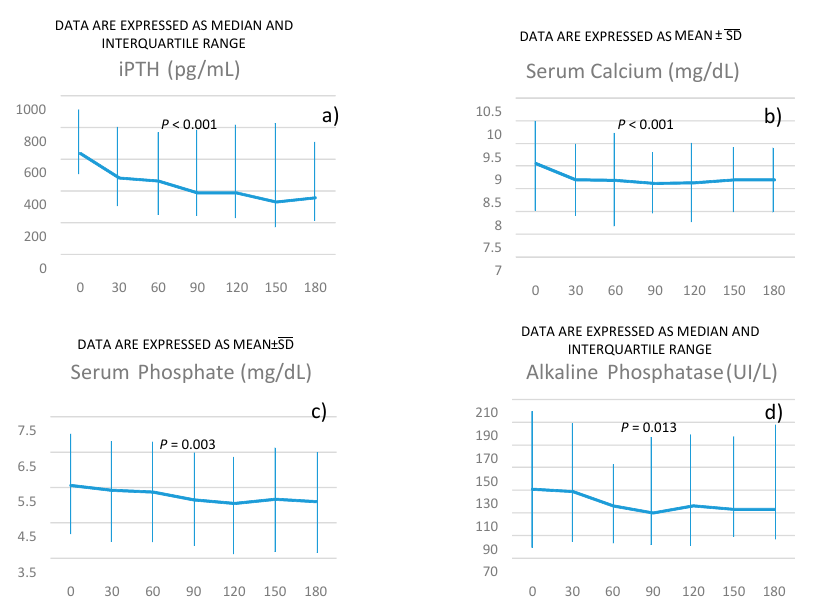
Figure 1. P for the trend of intact parathyroid hormone (iPTH) (panel a ), serum calcium (panel b ), serum phosphate (panel c ), alkaline phosphatase (panel d ) over time was obtained using linear regression models weighted for patients’ identification (see methods for more details).